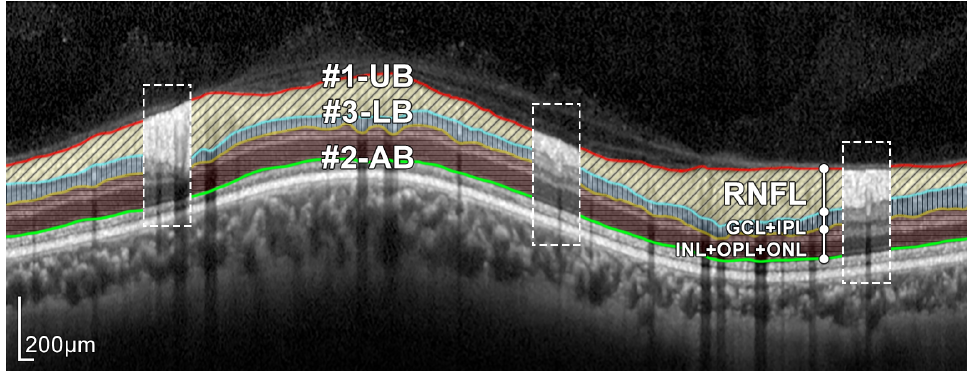
Figure 4. Layers of the retina from top to bottom. RNFL: retinal nerve fiber layer; GCL: ganglion cell layer; IPL: inner plexiform layer; INL: inner nuclear layer; OPL: outer plexiform layer; and ONL: outer nuclear layer. Boundary delineation in the segmentation process. #1-UB: upper boundary of the RNFL; #2-AB: auxiliary boundary corresponding to the lower boundary of the ONL; #3-LB, lower boundary of the RNFL. The dashed boxes exemplify some of the artifacts of the